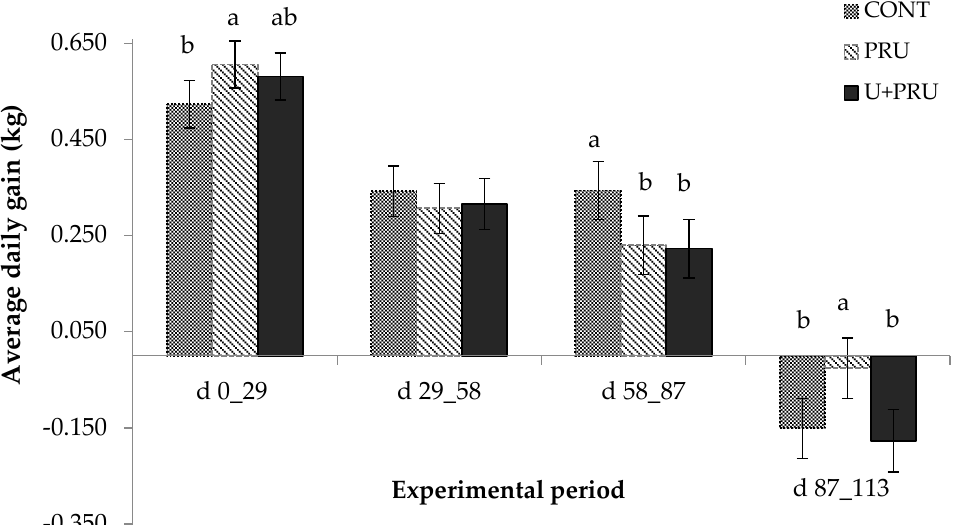
Figure 4. The mean and standard error means of on average daily gain in Nellore young bulls, as a function of the use of post-ruminal urea of the animals during the experimental period. Experimental days: d 0_29: First period, 29_58: Second period, 58_87: Third period, 87_113: Fourth period. Treat: Treatment; Per: Period; Treat × Per: Interaction between treatment and period. Lowercase letters on the line differ among treatments ( p ≤ 0.05).